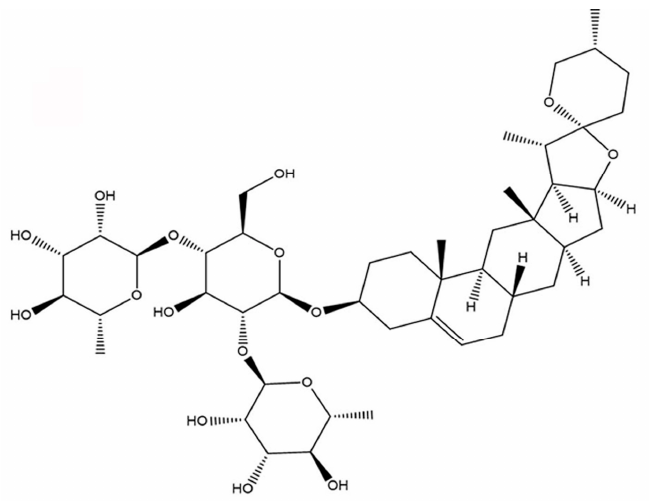
Figure 1. The chemical structure of dioscin.